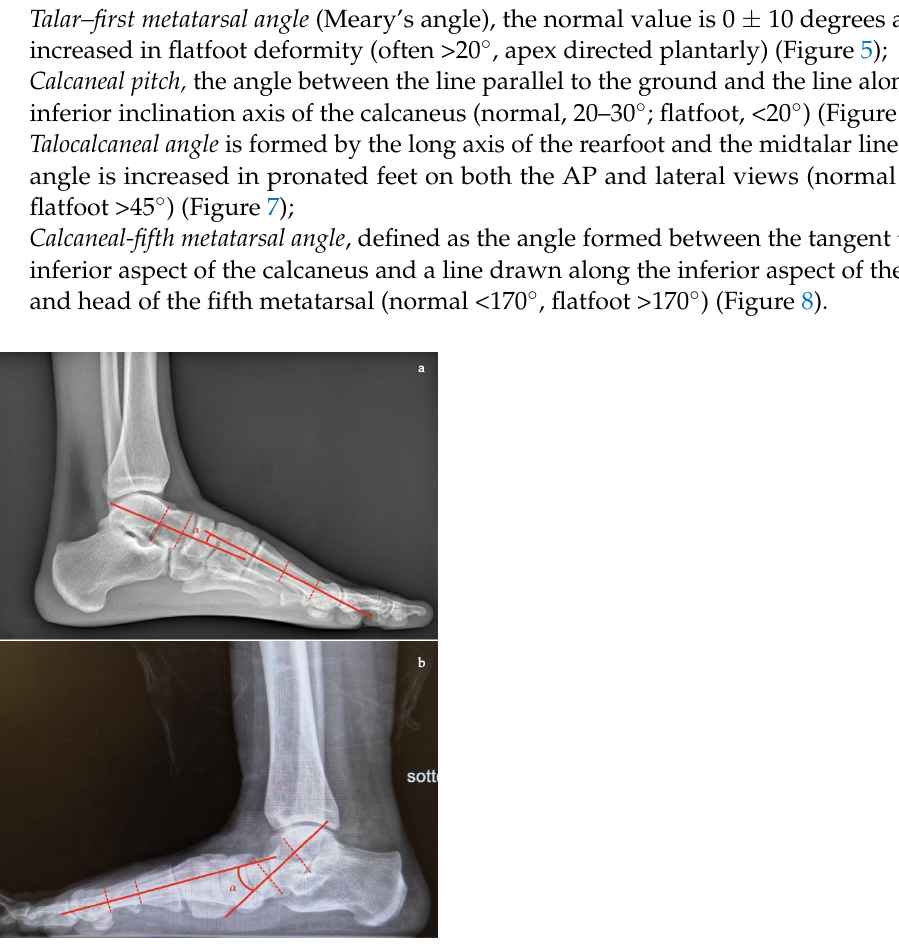
Figure 5. Talar-first metatarsal angle in the lateral view (Meary’s angle, the angle between the long axis of the talus and the long axis of the first metatarsal). ( a ) Normal foot, 4°; ( b ) pathological flatfoot, 30°.